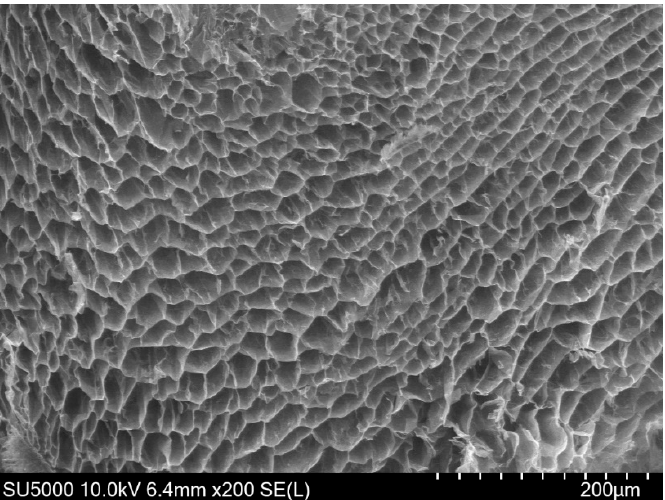
Figure 3. SEM image of the hydrogel porosity taken from the fracture surface of the sample. Gelatin is the denatured form of collagen, showing high biocompatibility. Selecting